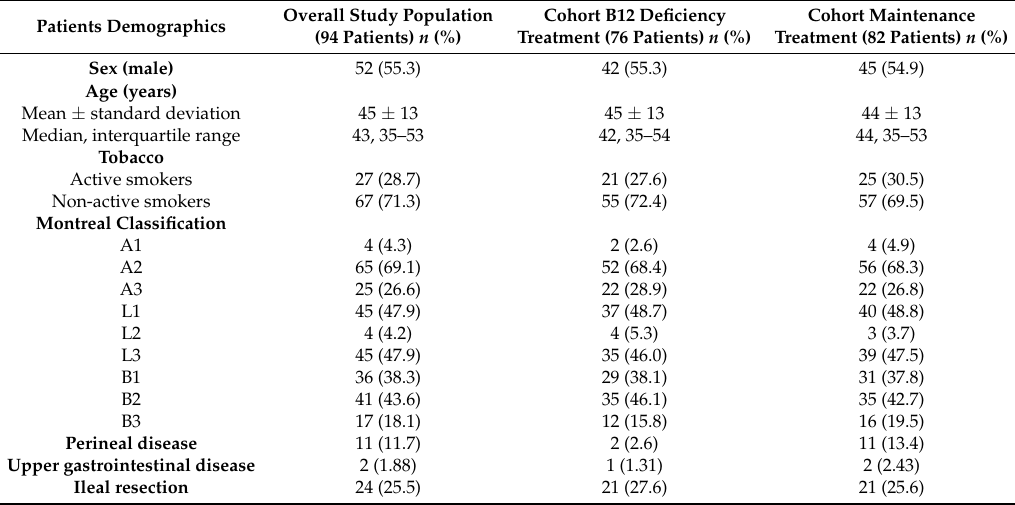
Table 1. Clinical and demographic characteristics of the study population.